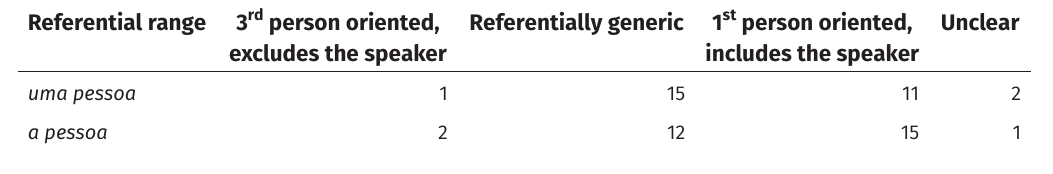
Table 2: Referential scope of a/uma pessoa